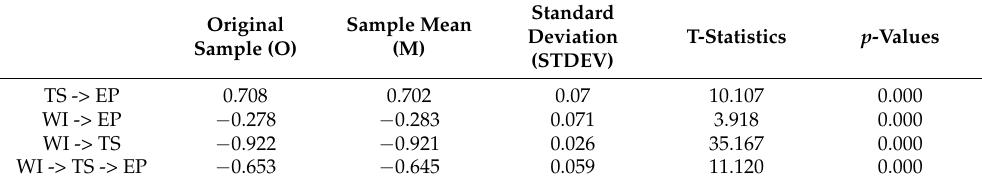
Table 5. Relationship of the